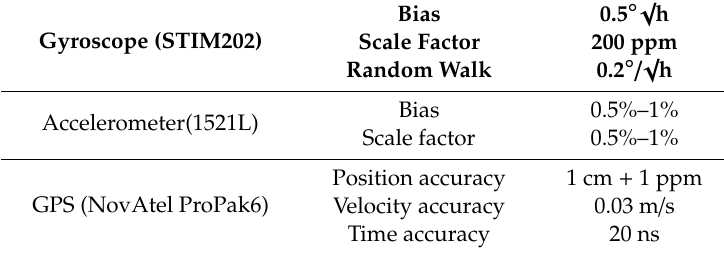
Figure 10. Experimental facilities. Table 1. Characteristics of the Micro-Electro-Mechanical System based Inertial Navigation Systems (MEMS-INS)/GPS.